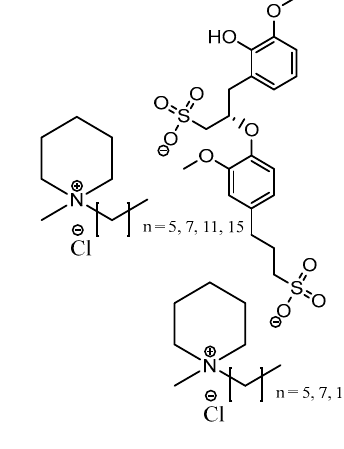
Figure 17. Metathesis of lignosulfonate-based ionic liquids.